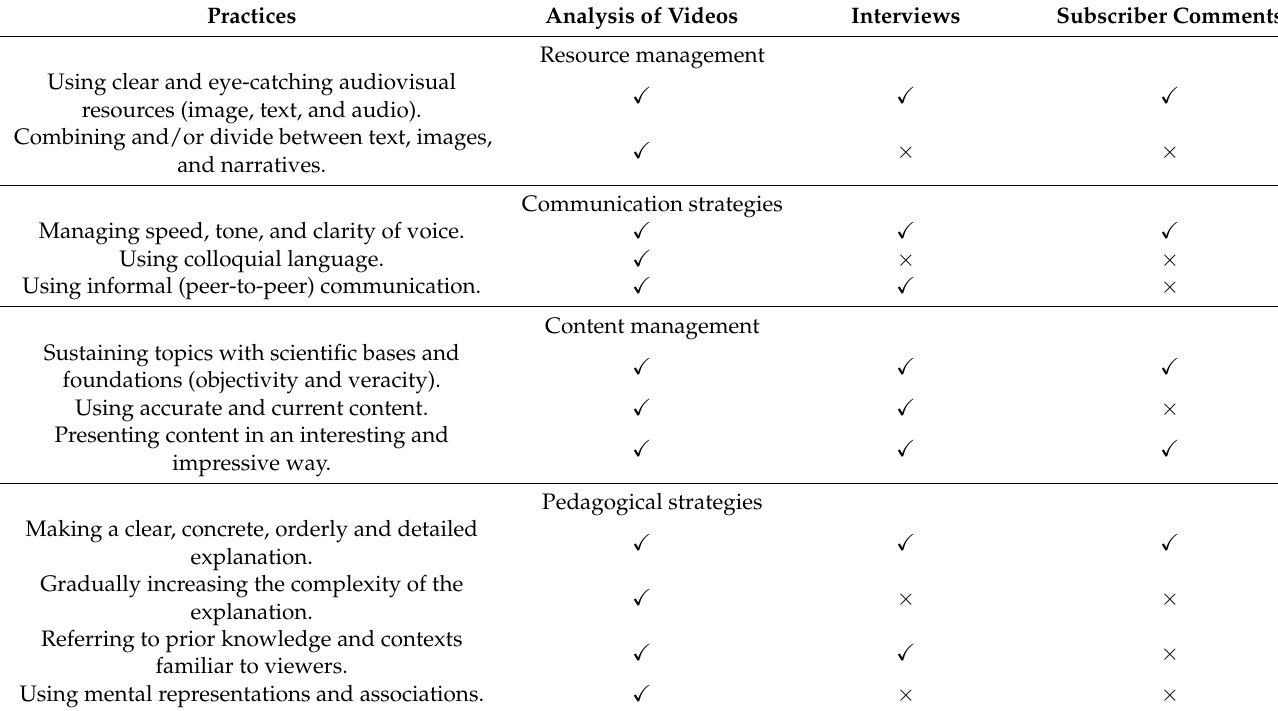
Table 2. EduTubers’ best practices found from video analysis (40), interview with EduTubers (4), and subscribers’ comments